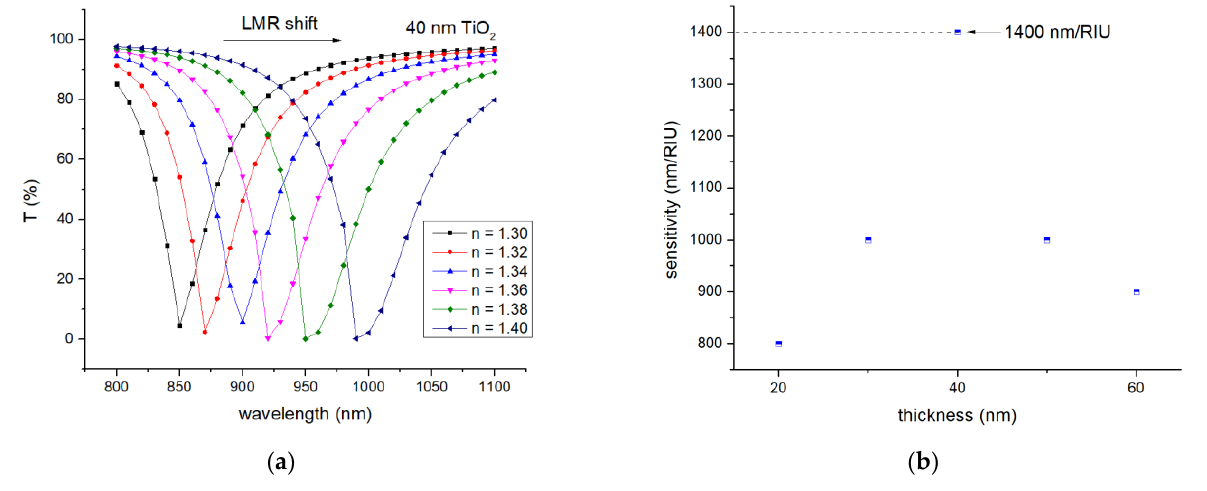
Figure 5. LMR sensor sensitivity: ( a ) LMR shift with a change in the refractive index of the medium; ( b ) influence of lossy coating thickness on sensitivity.